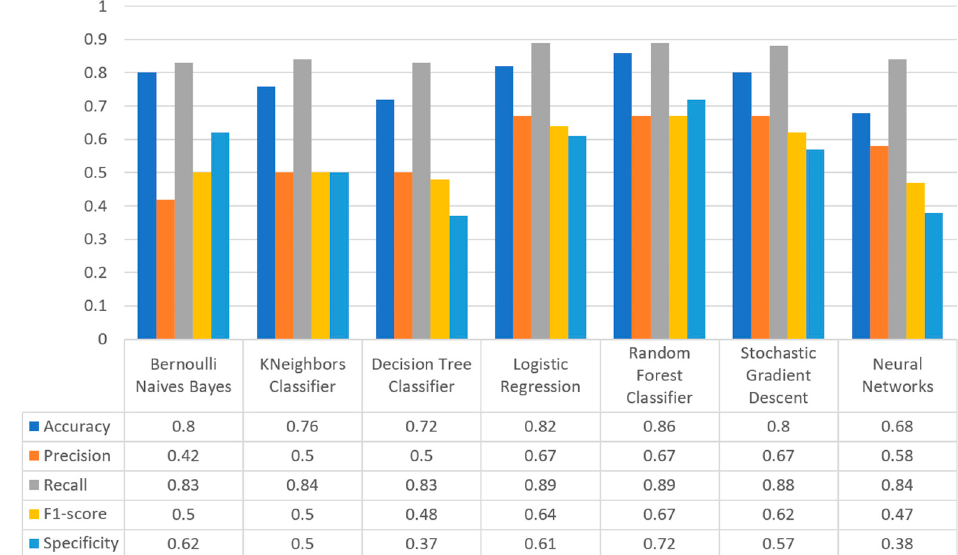
Figure 23. Performance comparison in the heart failure use case.